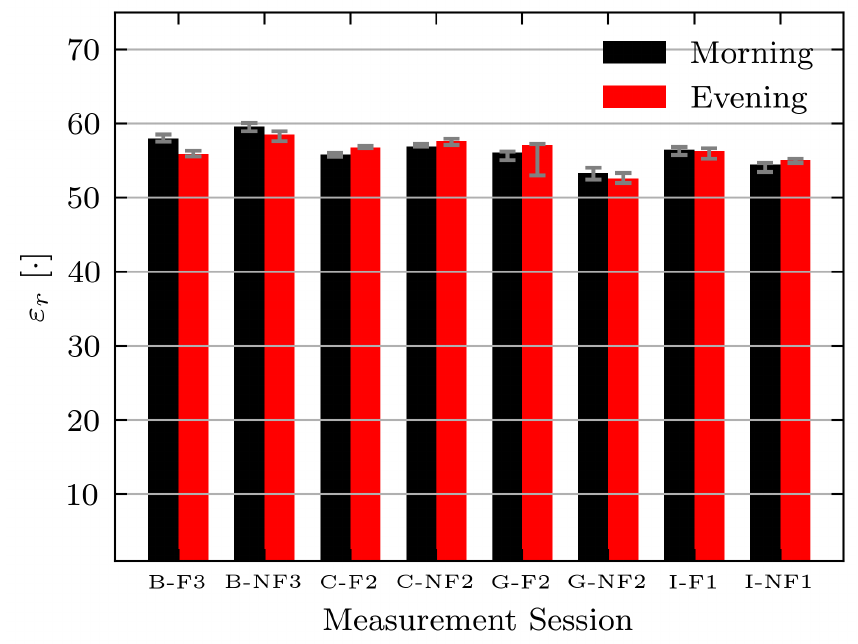
Figure 12. Estimated permittivity of Volunteers B, C, G, and I while fasting (F) and not fasting (NF) on select measurement days. Bars indicate median measurement session value and error bars indicate minimum and maximum